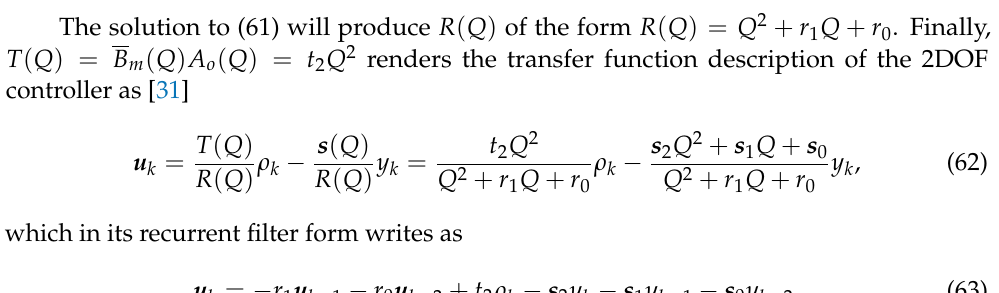
Figure 4. Step response of the OE identified model [31].